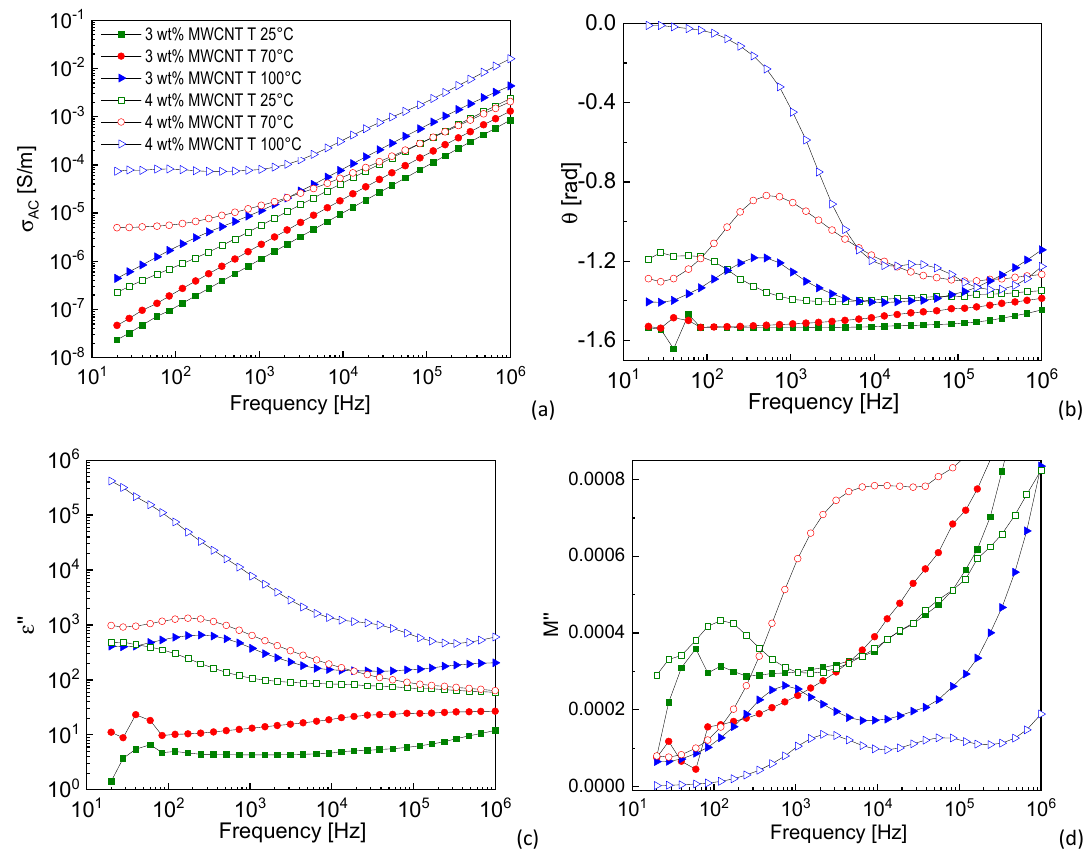
Figure 3. ( a ) σ AC , ( b ) phase angle, ( c ) ε ” and ( d ) M” of 3 and 4 wt%-multi-walled carbon nanotube (MWCNT) nanocomposites manufactured at temperature of the mold 25-70-100 °C (tests executed in P1; graph legend reported in ( a ) is valid for all the graphs).